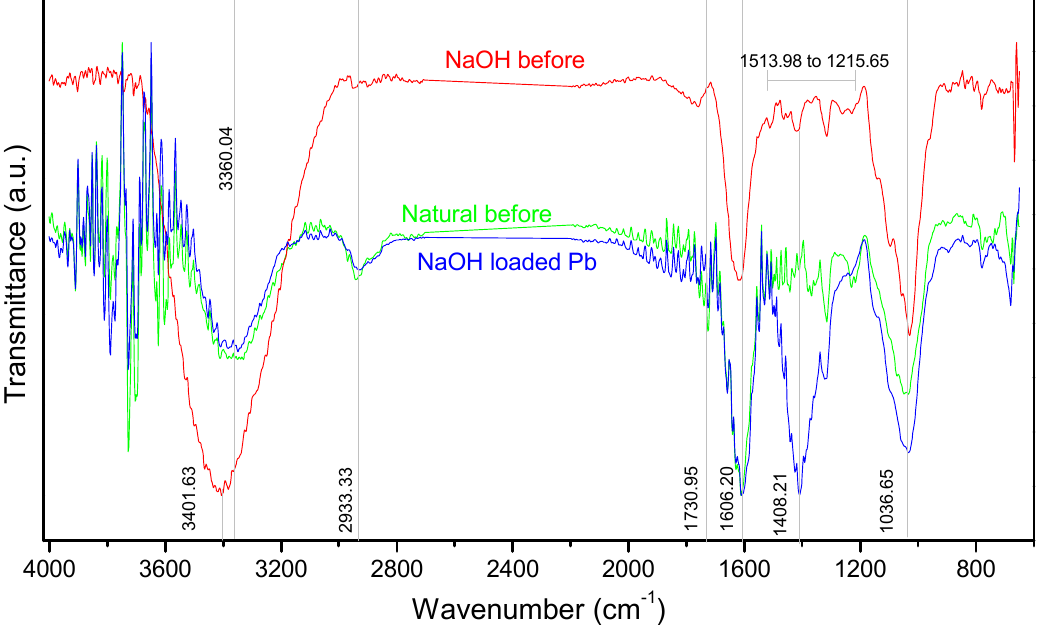
Figure 4. Spectrum FT-IR of Natural and washed with NaOH adsorbents, before and after contact with Pb(II) ions.